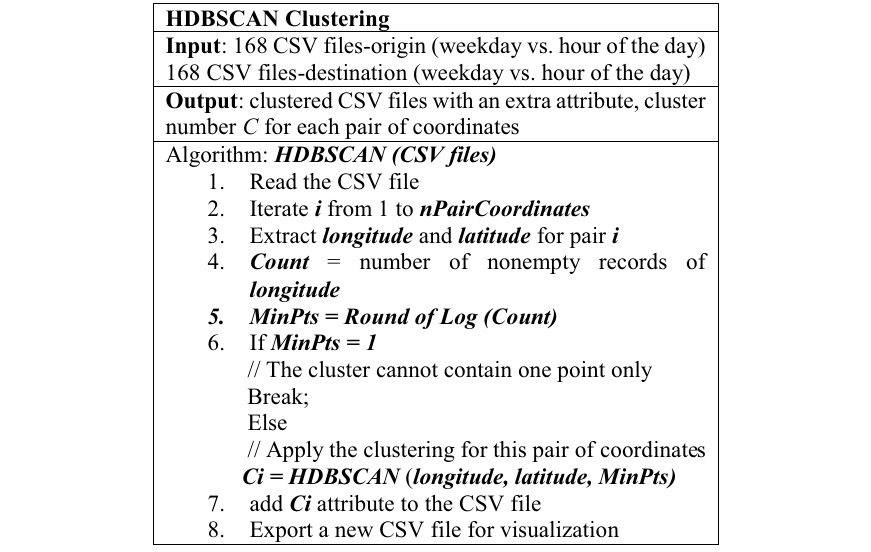
Fig. 3 HDBSCAN clustering Pseudo-Code, based on